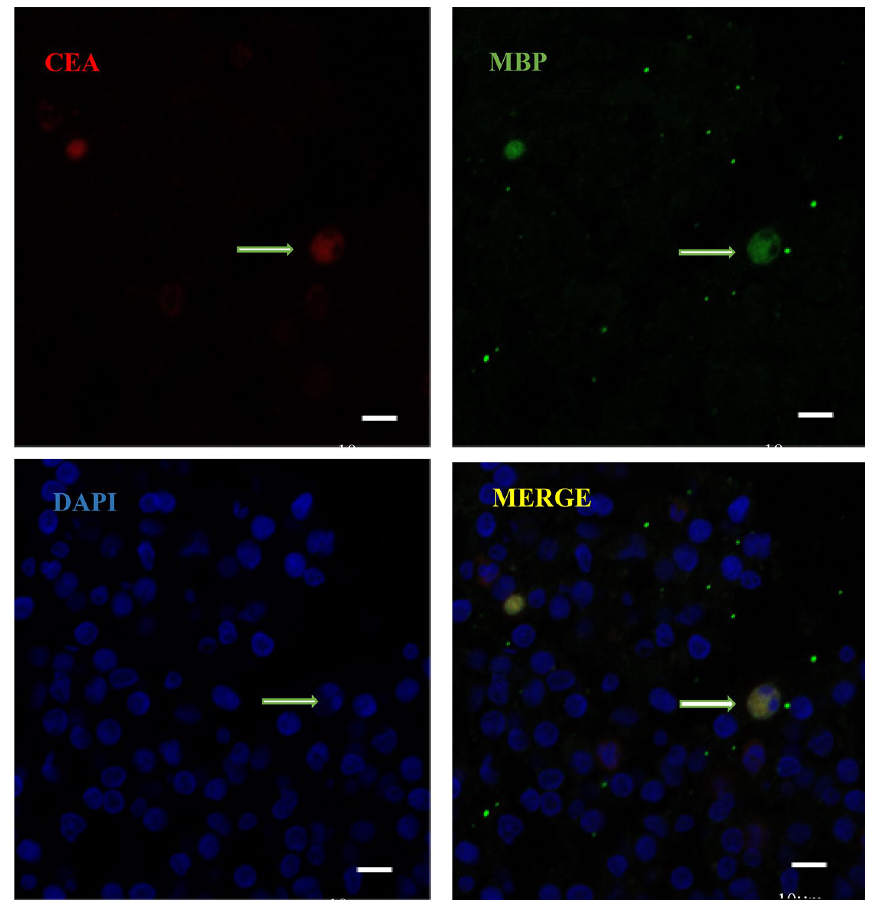
Figure 5. Lung section with a MBP–positive cell colabeled with CEA antigen localized on Cytoplasm, as indicated by the arrow. Scale bars = 10 μm. Dual immunofluorescence was performed using the eosinophils marker MBP (green) and the CEA Monoclonal Antibody (RED). Nuclei stained with DAPI (blue).Both double-labeling immunofluorescence assays were performed in lung section because of their positive induced in eosinophils . DAPI, 4 ′ ,6 ′ -diamino-2-phenylindole; MBP (also called Anti-PRG2 rabbit polyclonal